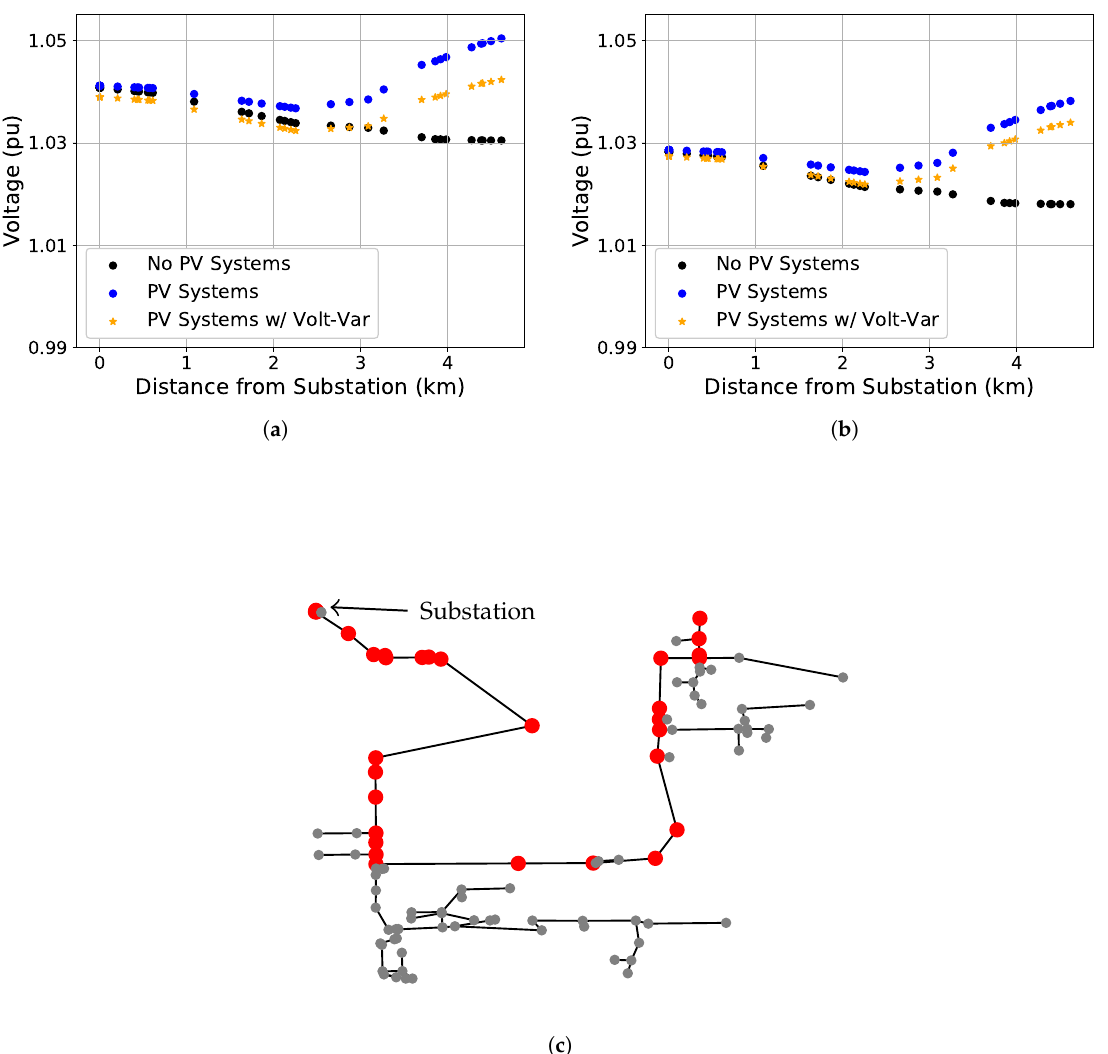
Figure 10. Two large systems located at the end of the path described in ( c ) caused the voltage to increase. Enabling the Volt-Var curve capabilities in each of the PV systems and using the conventional regulators provided voltage support that avoided a voltage violation. ( a ) Voltage Profile w/out Regulation; ( b ) Voltage Profile w/Regulation; ( c ) Voltage Profile Path.